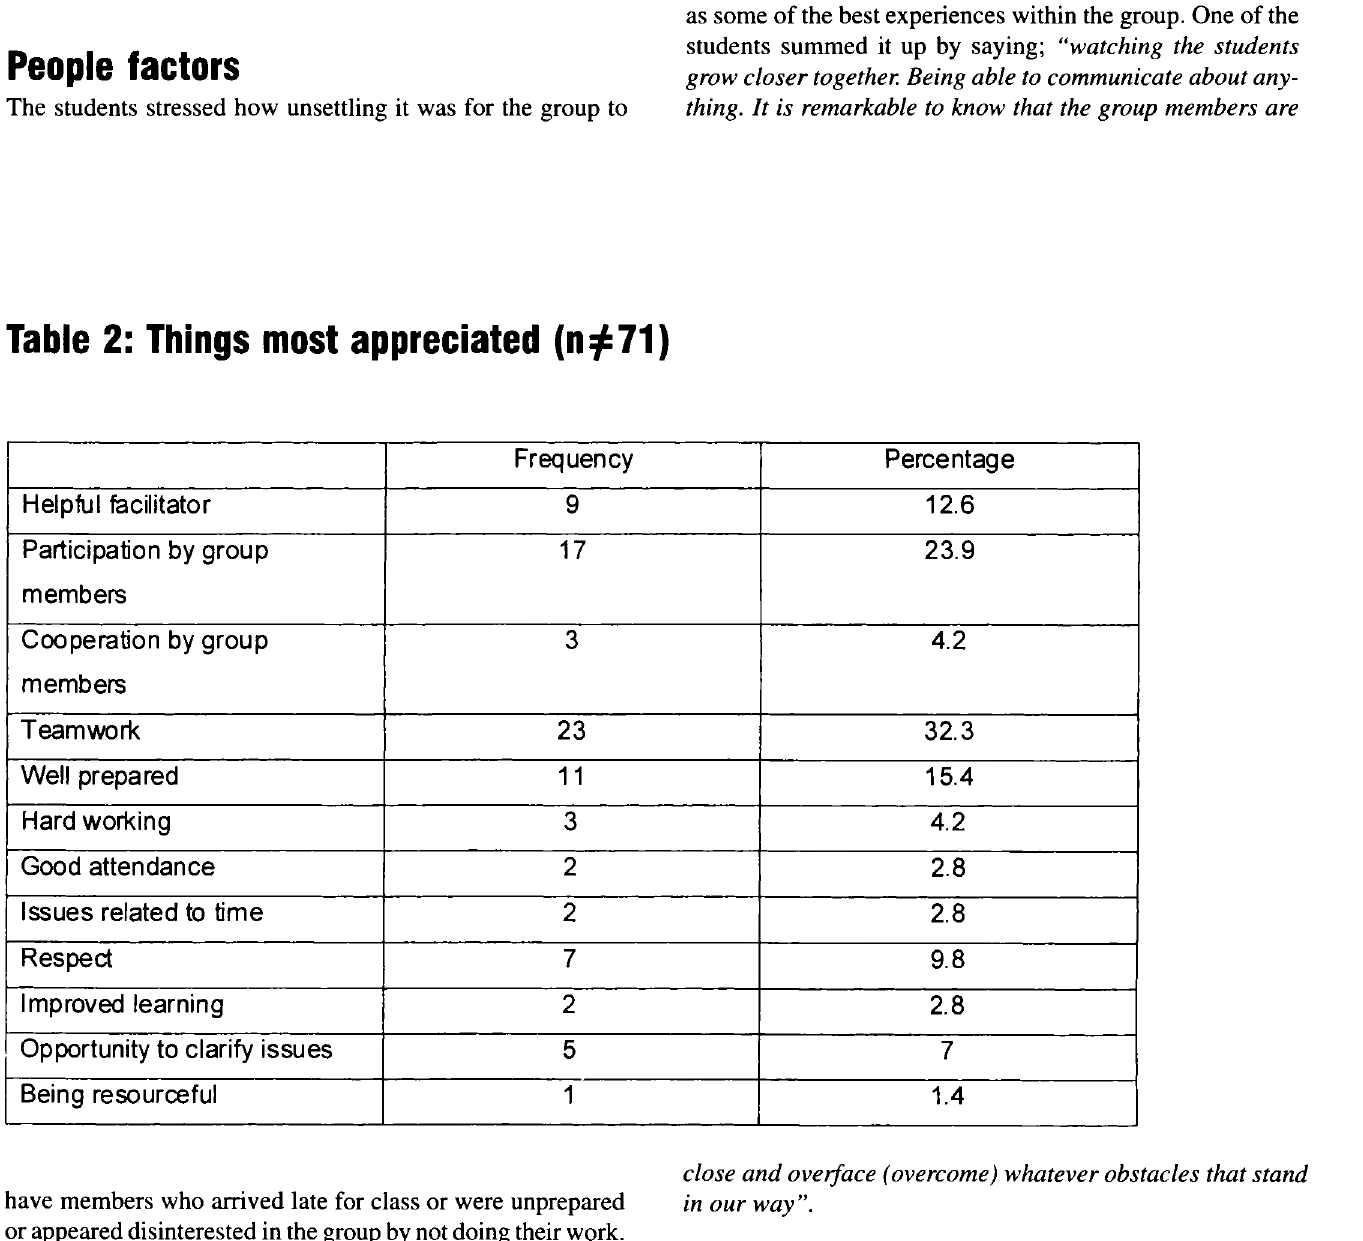
Table 2: Things most appreciated ( n ^ 7 1